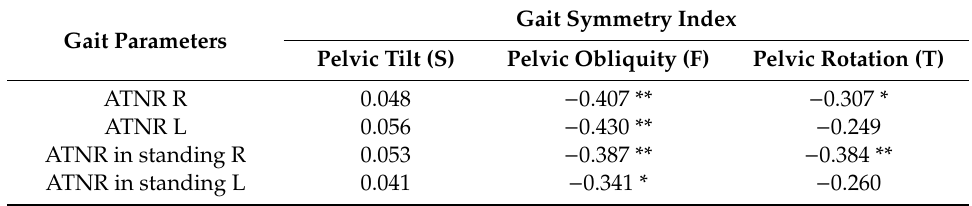
Table 2. Spearman correlation between asymmetrical tonic neck reflex and gait symmetry index. Gait Symmetry Index Gait Parameters Pelvic Tilt (S) Pelvic Obliquity (F) Pelvic Rotation (T) ATNR R 0.048 − 0.407 ** − 0.307 * ATNR L 0.056 − 0.430 ** − 0.249 ATNR in standing R 0.053 − 0.387 ** − 0.384 ** ATNR in standing L 0.041 − 0.341 * −